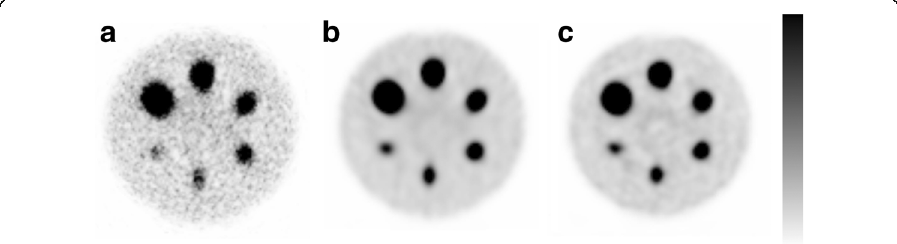
Fig. 3 Reconstructed SPECT images of the Jaszczak phantom filled with 177 Lu activity in the spheres and the background. The activity concentration ratio between the spheres and background was equal to 25. a AC-OSEM. b RRC-OSEM. c SARec OSEM